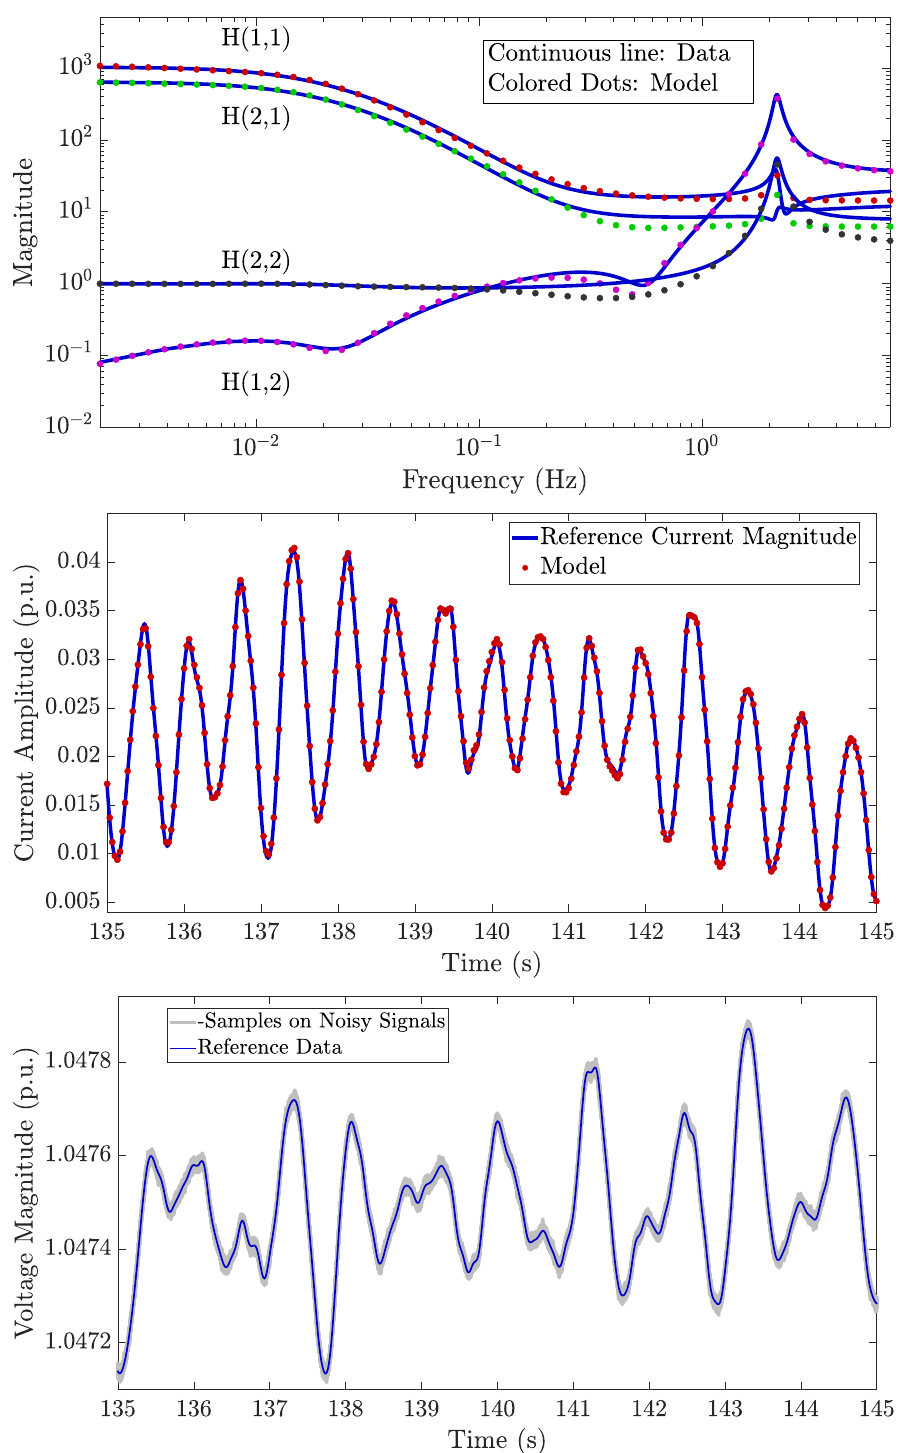
Figure 5. Generator model training from noisy data (SNR = 32). Top panel: frequency responses. Middle panel: small signal current magnitude. Bottom panel: noise-corrupted input training signals (samples from a cloud of R = 100 different realizations depicted with a shade of